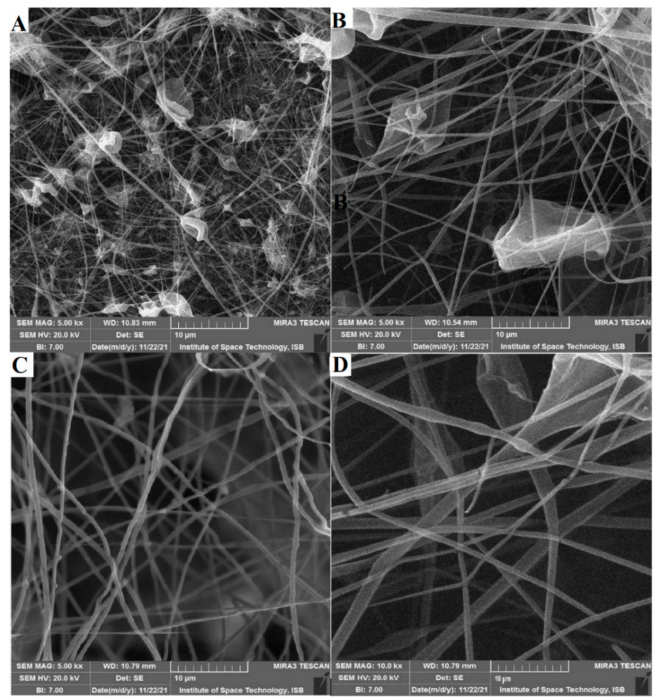
Figure 9. SEM images of nanofibers (voltage: 12 kV; gap: 6 cm): ( A ) CA_0.3% HS, ( B ) CA_0.5% HS, ( C ) CA_0.7% HS, and ( D ) CA_0.8% HS.